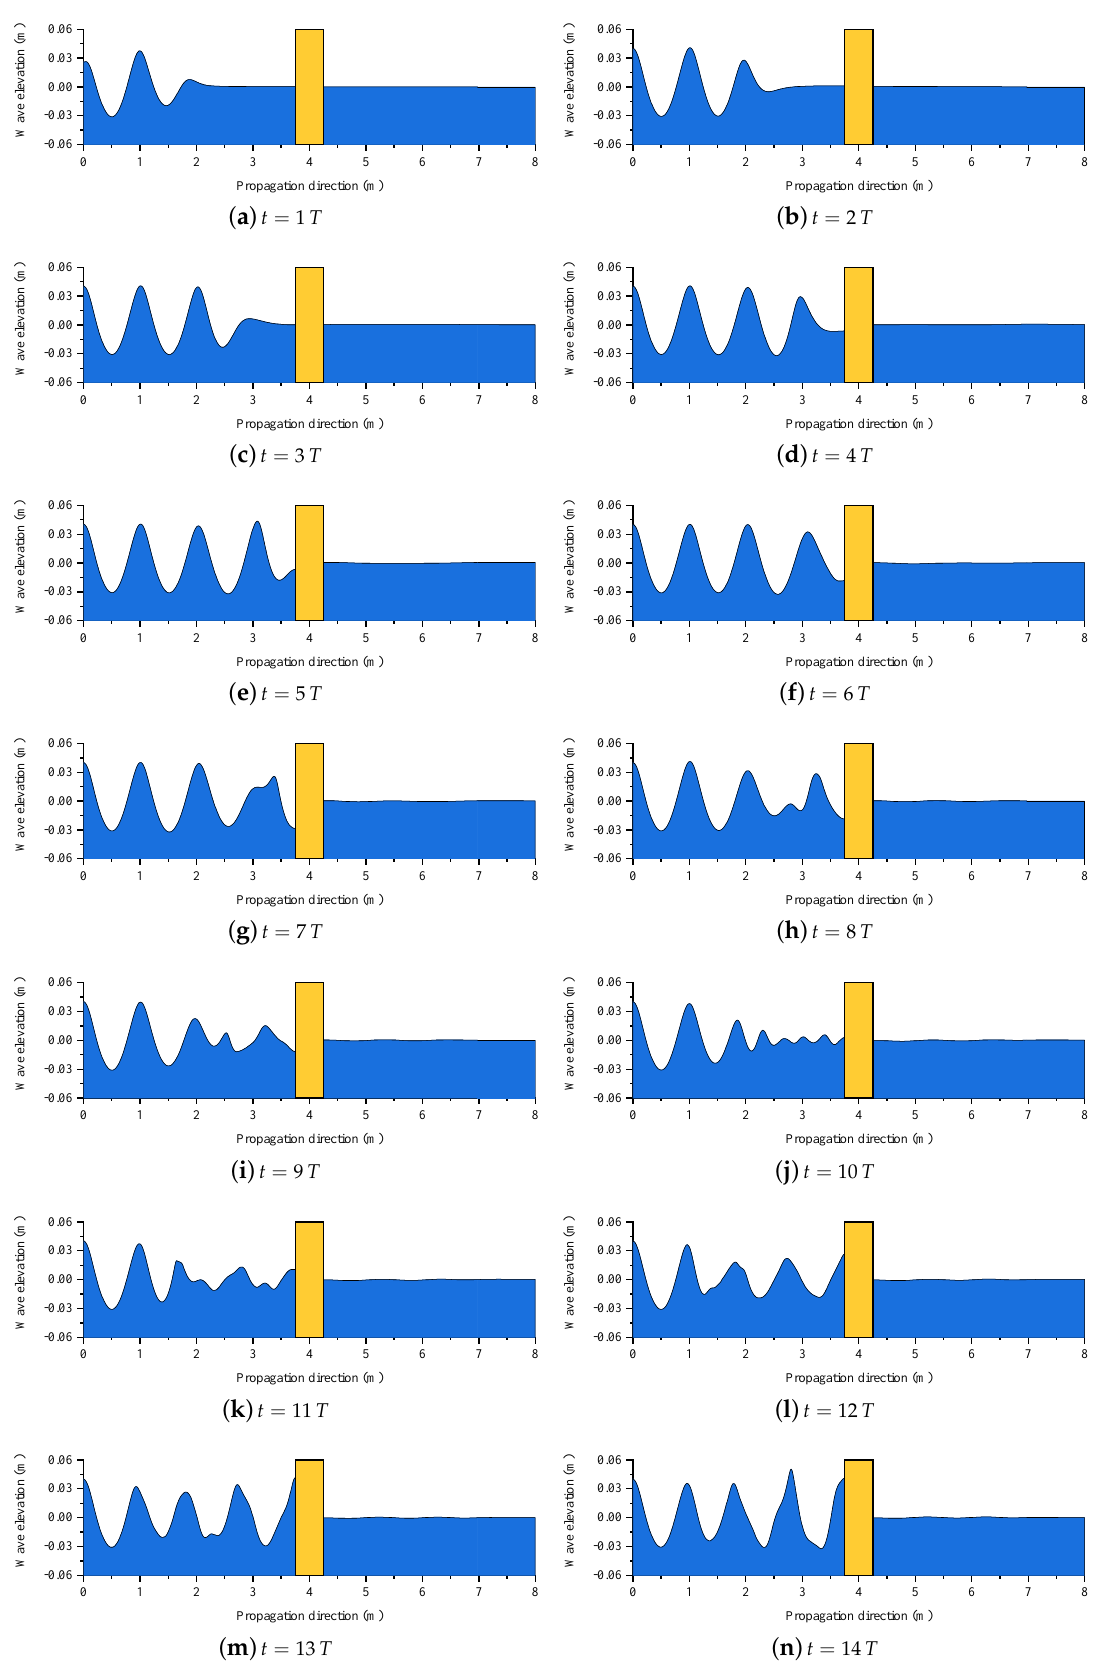
Figure 9. Profiles of free surface along the developed NWF at different time slices with wave length λ = 1.0m and wave height H =